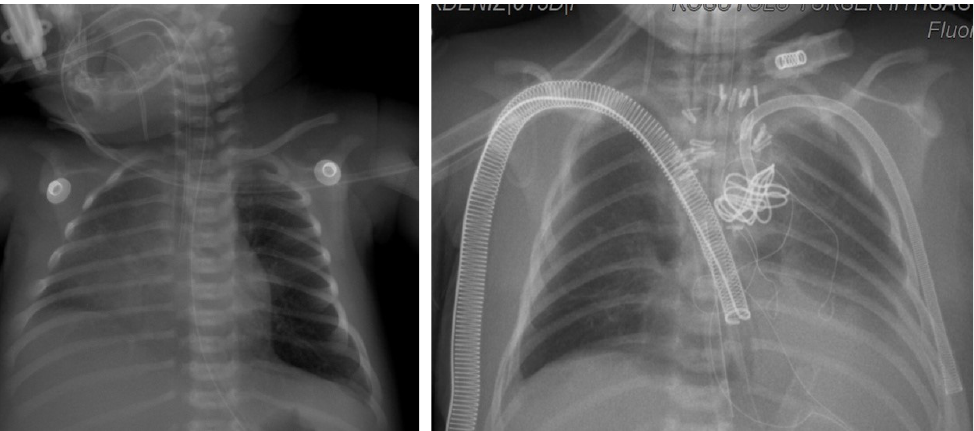
Fig. 3 - Preoperative and postoperative tele-imaging of the patient whose coronavirus disease 2019 real-time polymerase chain reaction (RT-PCR) test was negative but whose mother’s RT-PCR was positive and who underwent Norwood stage 1 operation.